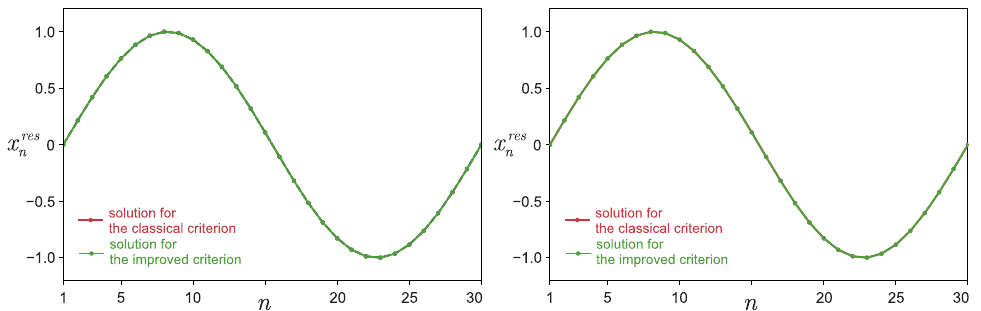
σ 2 s ∆ 2 depending on the iteration number s . ( b ) Graph of (cid:107) r ( s ) (cid:107) 2